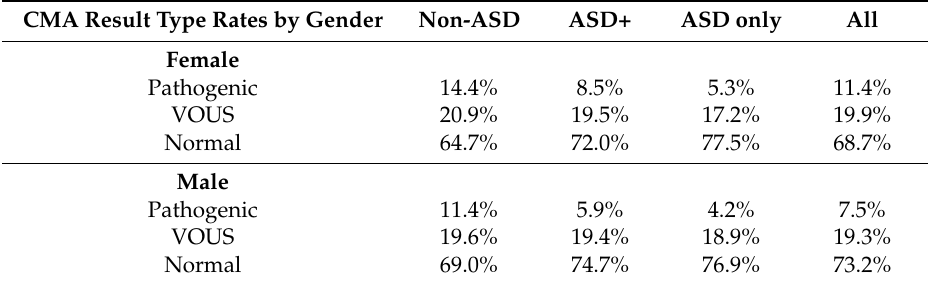
Table 7. Rates of diagnostic findings on CMA by gender and diagnostic referral codes grouping. CMA Result Type Rates by Gender Non-ASD